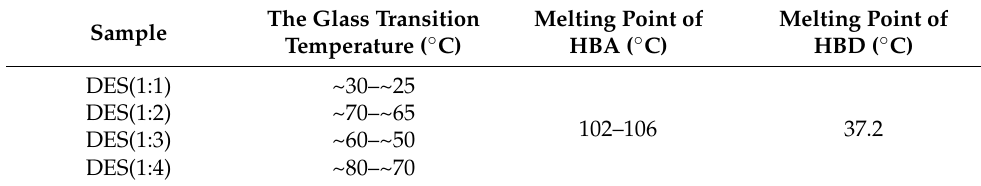
Table 4. Glass transition temperature and melting point of the DESs.